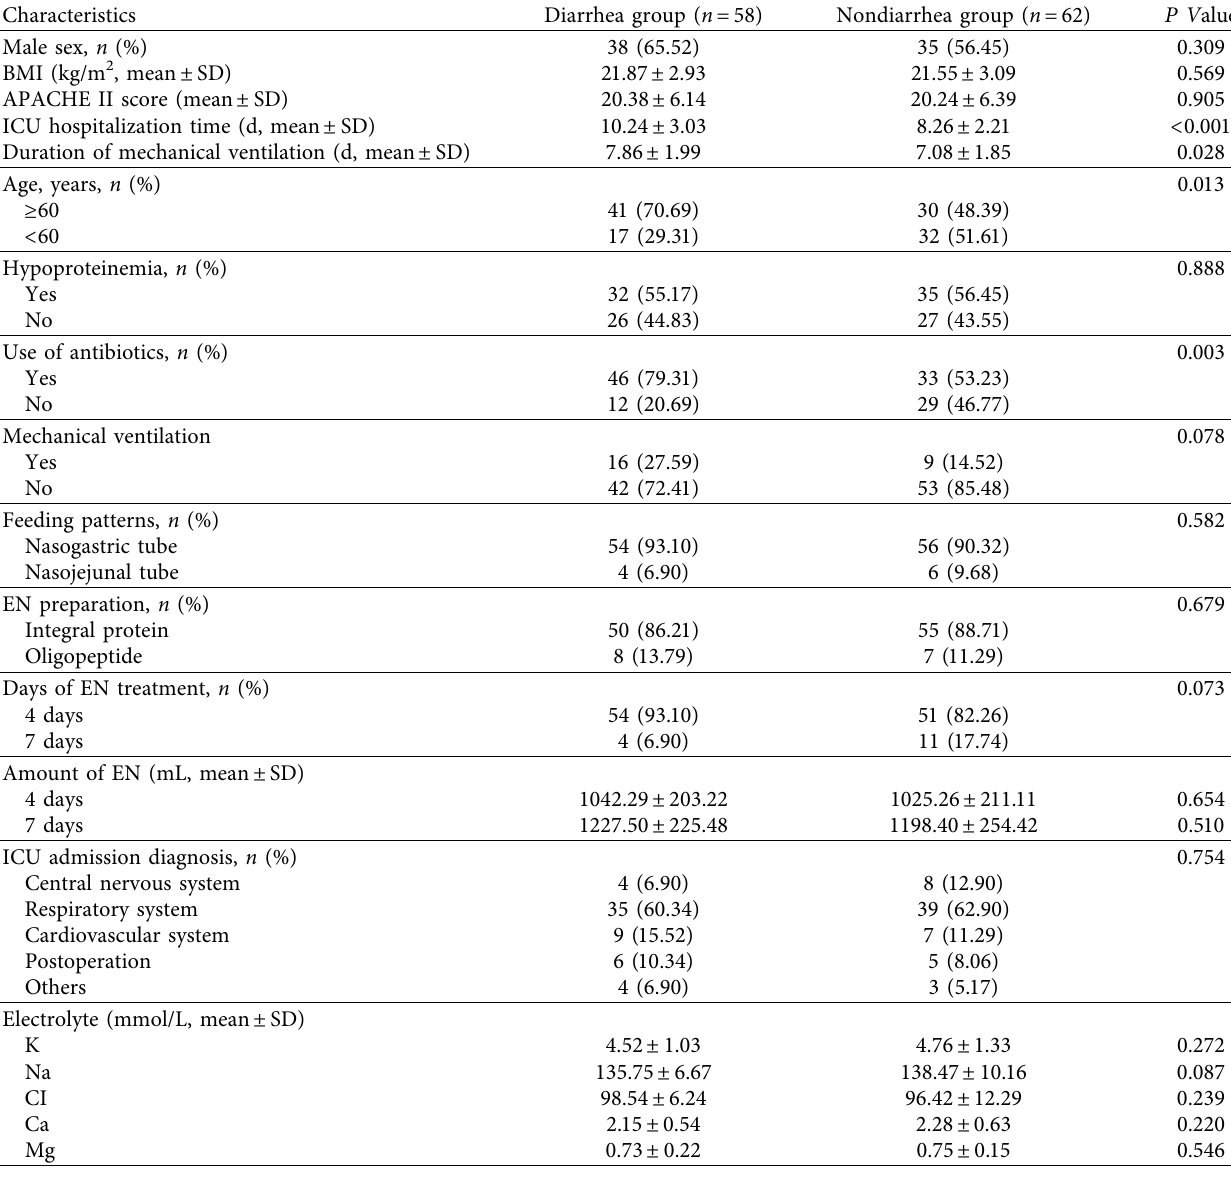
Table 2: Single factor analysis of diarrhea condition.